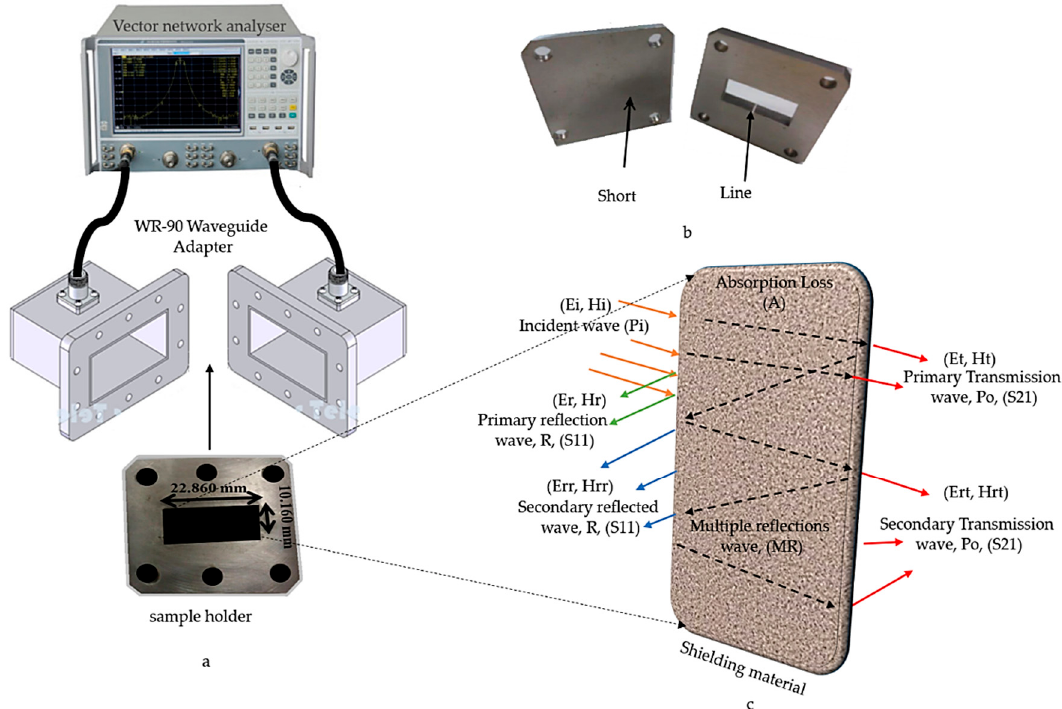
Figure 3. ( a ) Electromagnetic properties measurement setup, ( b ) Thru-Reflect-Load (TRL) calibration Line and short for rectangular waveguide, and ( c ) Schematic showing the mechanism of the passage of the wave inside the material under test.